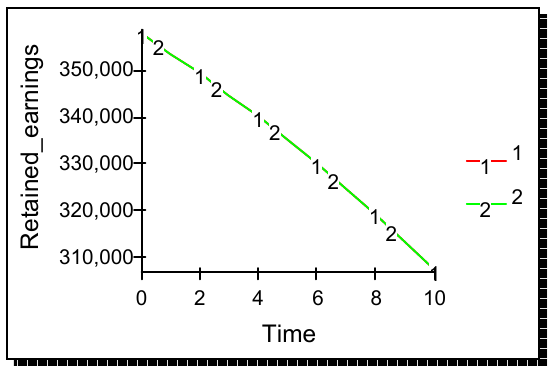
Figure 5. Unilateral coupled demand tilting advertising σ 11 = 1.5 × 10 − 10 ; σ 12 = − 1.5 × 10 − 10 ; σ 22 = σ 21 =0.